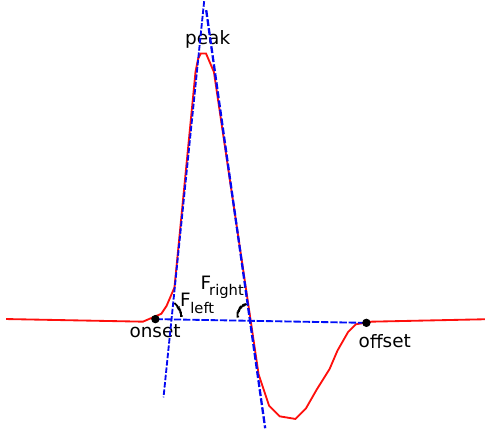
Figure 9. Features related to slopes based on